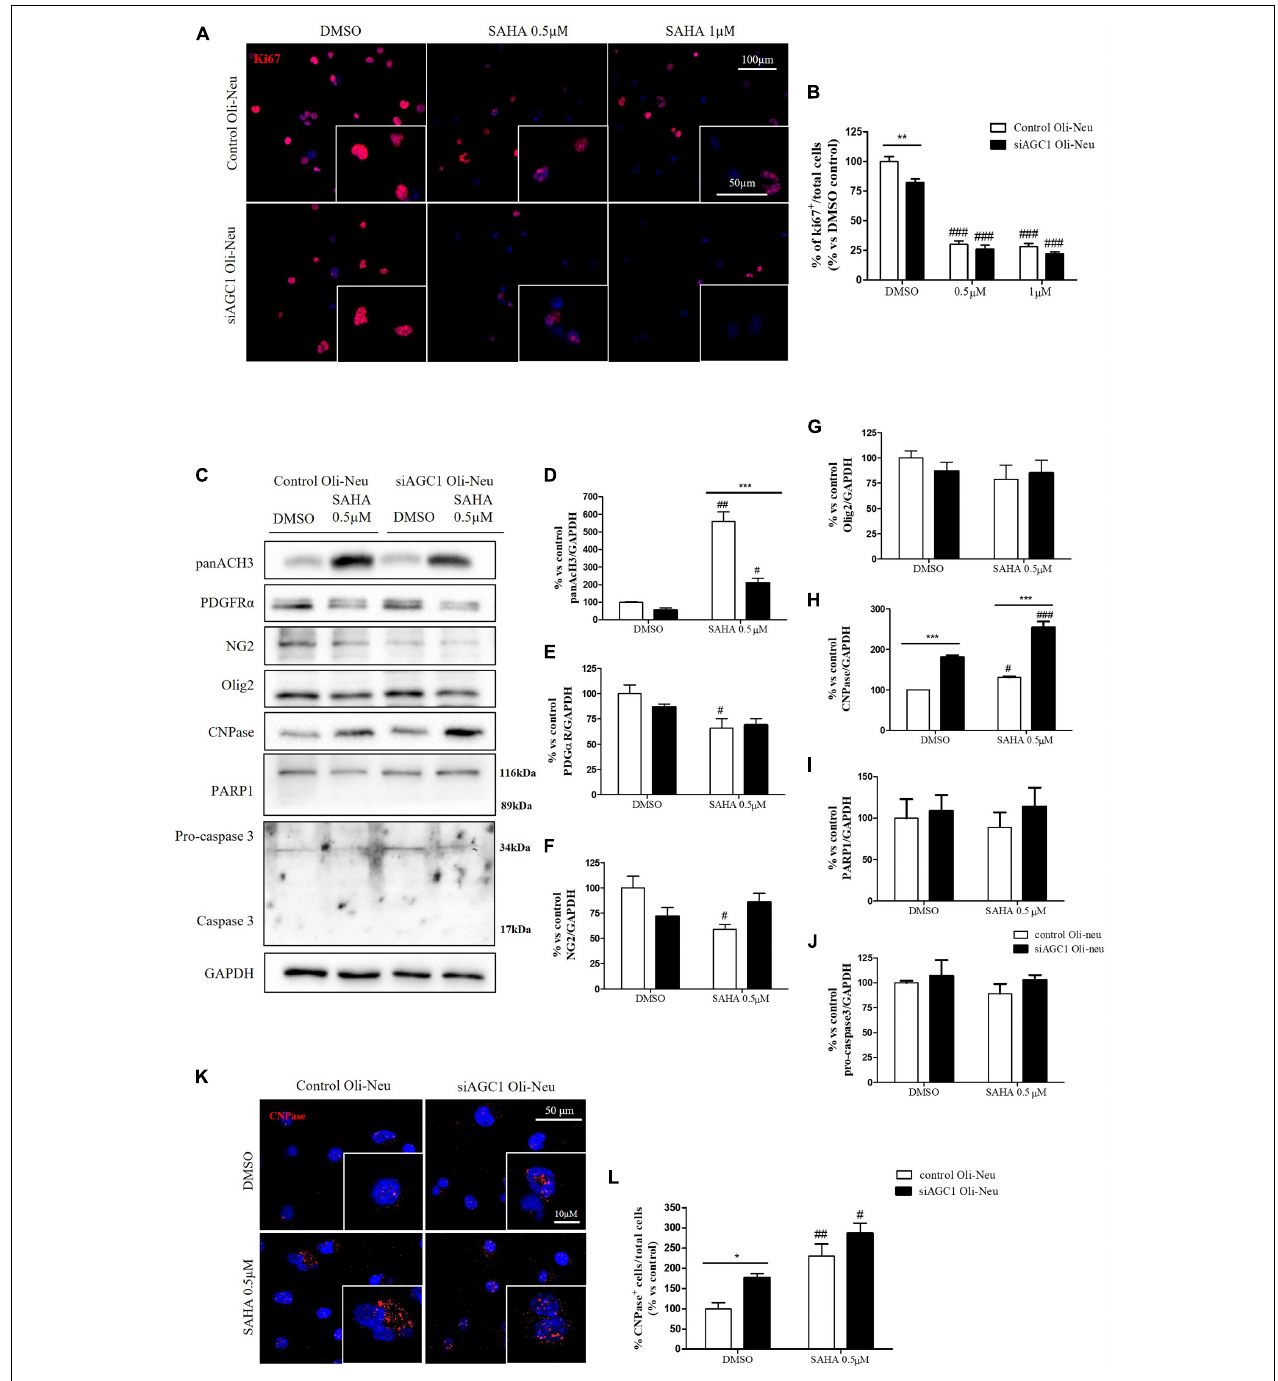
FIGURE 9 | Suberanilohydroxamic acid (SAHA)-mediated HDACs inhibition differentially reduces proliferation and promotes differentiation in control and AGC1-silenced Oli-Neu cells. Immunofluorescence staining of Ki67 proliferation marker (A) and Ki67 + cell count analysis (B) in Oli-Neu cells after 24 h treatment with 0.5 or 1.0 µ M SAHA. Values are expressed as the ratio of Ki67 + cells (red)/total cells; nuclei were labeled with DAPI. Values are mean ± SD of 3 independent experiments; 3 different fields were acquired for each condition. 40X objective; 50 and 100 µ m bar scale. WB and relative densitometries of panAcH3 (C,D) , PDGFR α (C,E) , NG2 (C,F) , Olig2 (C,G) , CNPase (C,H) , PARP1 (C,I) , and pro-caspase3 (C,J) expression in OliNeu cells after 48 h treatment with 0.5 µ M SAHA. Immunofluorescence staining of CNPase (K) and CNPase + cell count analysis (L) in OliNeu cells after 48 h treatment with 0.5 µ M SAHA. Values are expressed as the ratio of CNPase + cells (red)/total cells; nuclei were labeled with DAPI. Three different fields were acquired for each condition. Values are mean ± SD of at least 3 independent experiments. 40X objective; 50 and 10 µ m bar scale. # p < 0.05, ## p < 0.01, ### p < 0.001, compared to DMSO control, respectively; * p < 0.05, ** p < 0.01, *** p < 0.001, compared to each treated control; two-way ANOVA (Bonferroni’s post hoc test).